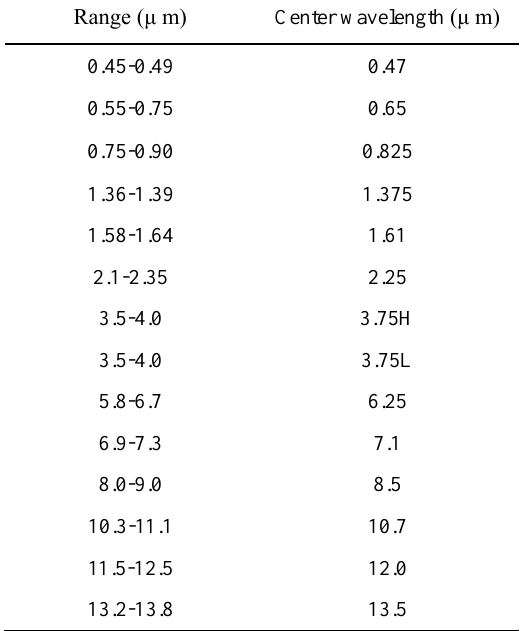
Table 1. Range and center wavelength of each channel of AGRI on FY-4A